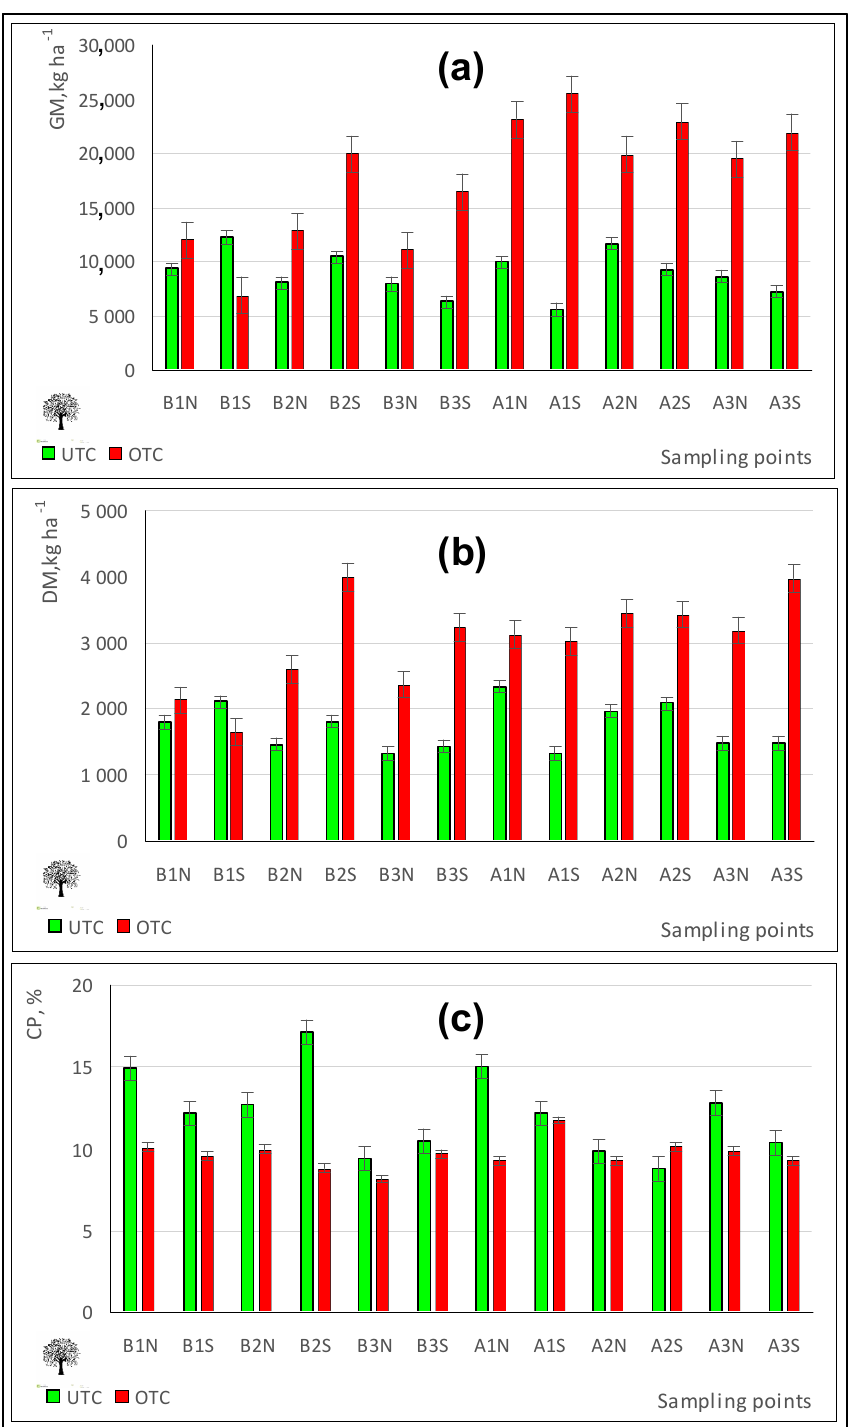
Figure 13. Pasture green matter, GM ( a ), dry matter, DM ( b ) and crude protein, CP ( c ) in April 2016, outside tree canopy (OTC) and under tree canopy (UTC).